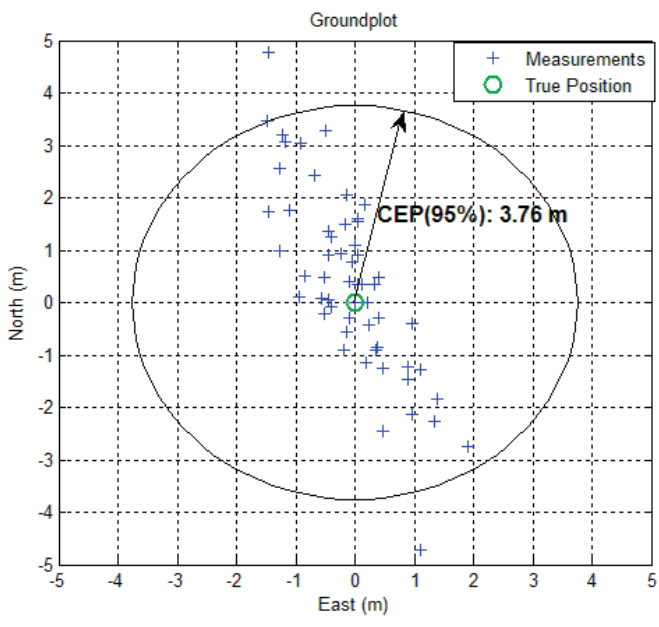
Figure 9. Horizontal error scatter plot.